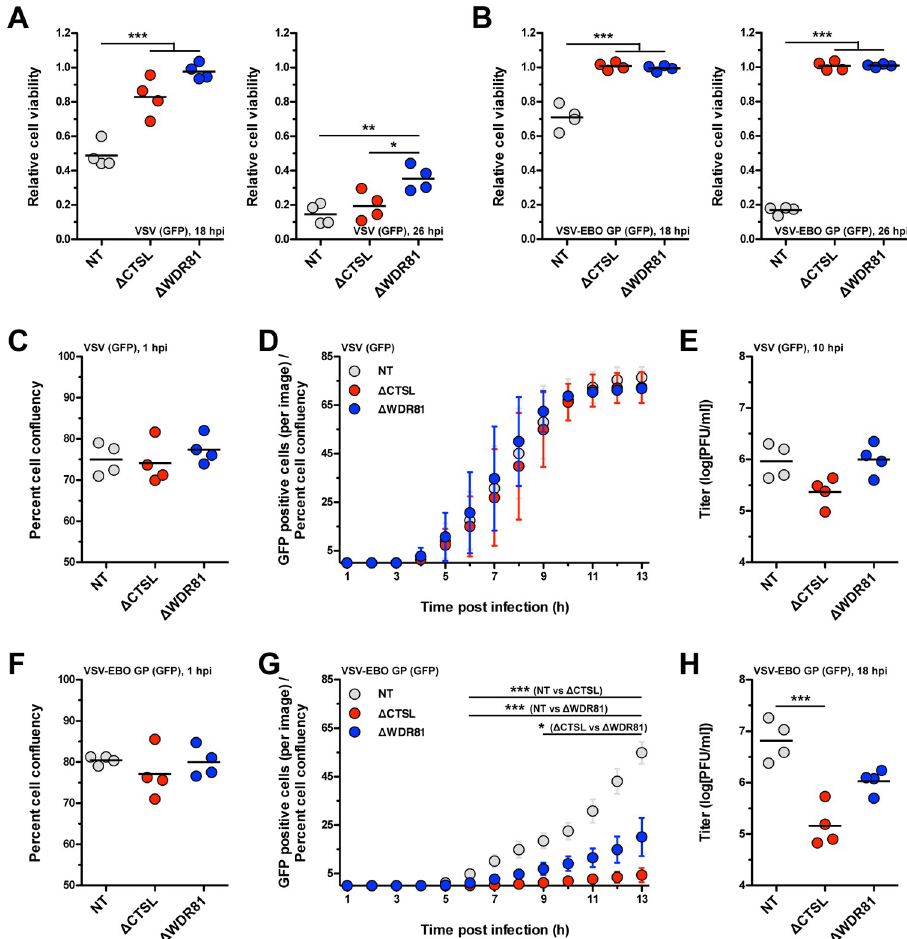
Fig 9. Infection of WDR81-deficient cells by VSV (GFP) or VSV-EBO GP (GFP). (A and B) Induction of cell death. NT, Δ CTSL, and Δ WDR81 cells were infected with VSV (GFP) (A) or VSV-EBO GP (GFP) (B) at 5 PFUs/cell. At 18 and 26 h post infection (hpi), the relative cell viability was measured using the CellTiter-Glo Luminescent Cell Viability Assay. Horizontal bars indicate the means; � , P � 0.05, �� , P � 0.005, ��� , P � 0.0005 (n = 4 biological replicates). (C, D, F, and G) Initiation of protein synthesis. NT, Δ CTSL, and Δ WDR81 cells were infected with VSV (GFP) (D) or VSV-EBO GP (GFP) (G) at 5 PFUs/cell. At the timepoints indicated in the figure, the number of total cells per image and the number of GFP positive cells per image were measured using the IncuCyte S3 Live-Cell Analysis System. The ‘Percent cell confluency’ at the 1 h timepoints is shown in panels C and F. Horizontal bars indicate the means (C and F); error bars indicate the standard deviations (D and G); � , P � 0.05, ��� , P � 0.0005 (n = 4 biological replicates). (E and H) Production of infectious virus. NT, Δ CTSL, and Δ WDR81 cells were infected with VSV (GFP) (E) or VSV-EBO GP (GFP) (H) at 5 PFUs/cell. At 10 (E) or 18 (H) hpi, the amount of infectious virus produced was measured using plaque assay. Horizontal bars indicate the means; ��� , P � 0.0005 (n = 4 biological